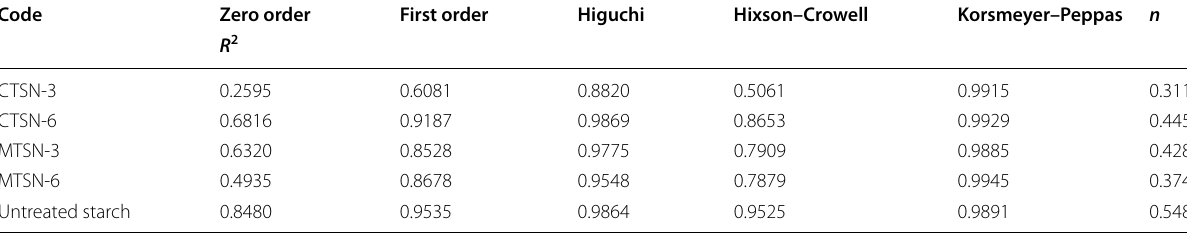
Table 10 Correlation coefficients ( R 2 ) obtained for ciprofloxacin-loaded nanoparticles Code Zero